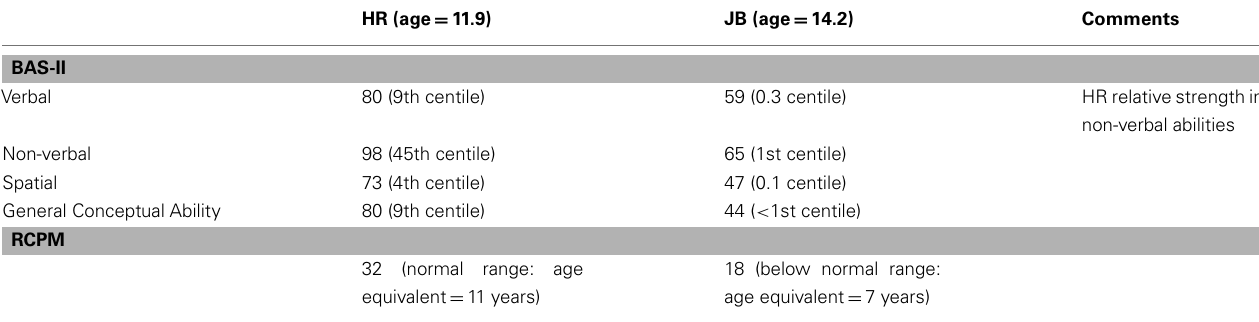
Table 1 | Psychometric tests.